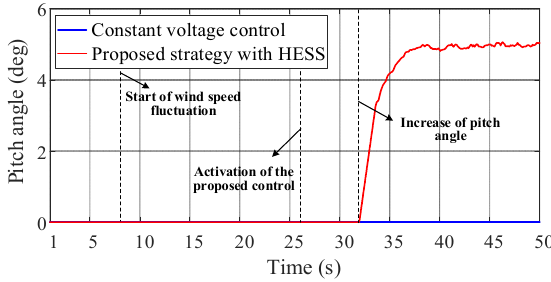
Figure 15. The pitch angle of the DFIG in case I. The real-time LRP–RPCD curve of the system under the constant voltage control is shown in Figure 16a, and the LRP curve decreases from 0.711 p.u. to 0.421 p.u., while the RPCD curve increases from 0.219 p.u. to 0.670 p.u. At the time of 25.753 s, the LRP of the wind farm is equal to the RPCD of the power grid and the corresponding rotor speed of the intersection is 1.118 rad/s satisfying ω in ≤ ω x < ω cr .